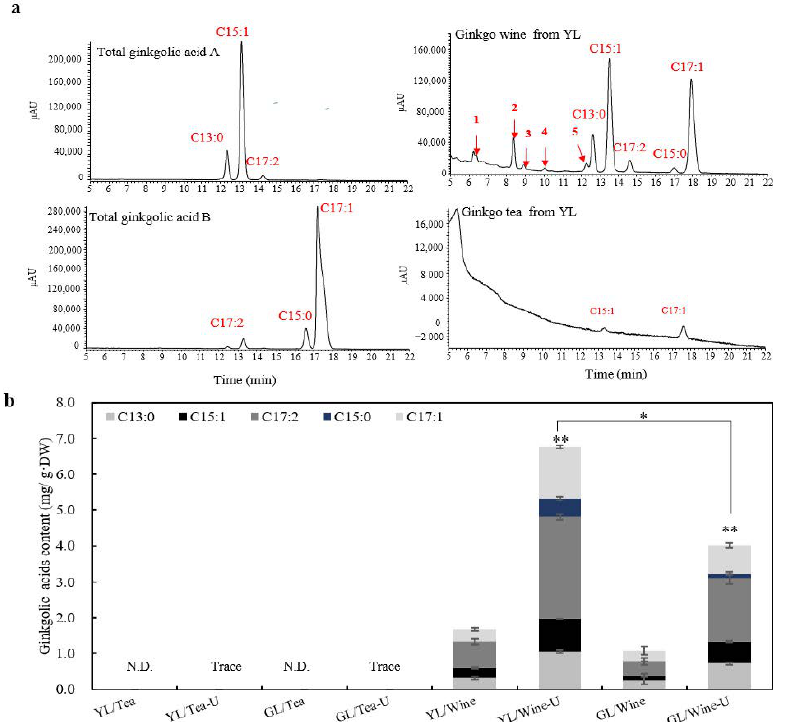
Figure 6. Characterization of the total ginkgolic acids in ginkgo tea and ginkgo wine. ( a ) HPLC chromatograms of ginkgo wine (right, upper panel) and ginkgo tea (right, lower panel) infusions for analyzing the total ginkgolic acids with authentic total ginkgolic acids A (left, upper panel) and B (left, lower panel). The red numbers 1–5 in the chromatograms represented the suspected newly identified ginkgolic acids peaks. ( b ) Quantification of the total ginkgolic acids in ginkgo tea and ginkgo wine. Ginkgolic acids were quantified and calculated with the specific standard curve plotted by HPLC with authentic substrates. Data are presented as mean ± SD. Asterisks denote t -test significance: * p < 0.05, ** p < 0.01, n = 3.